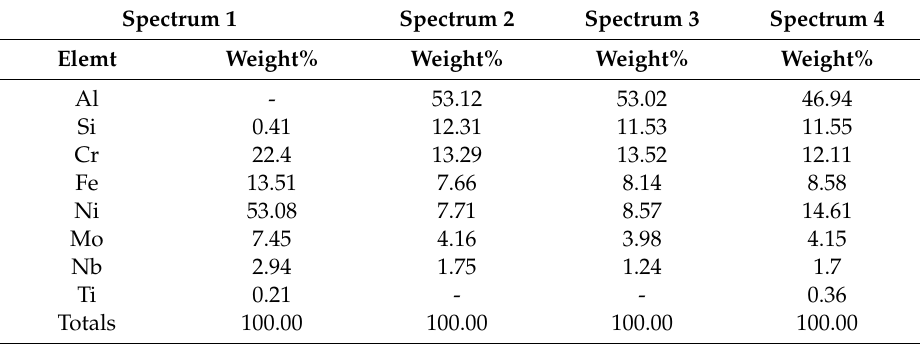
Table 7. E Ni 6625 / 680 ± 20 ◦ C / 120 min / AlSi9 EDX semi-quantitative